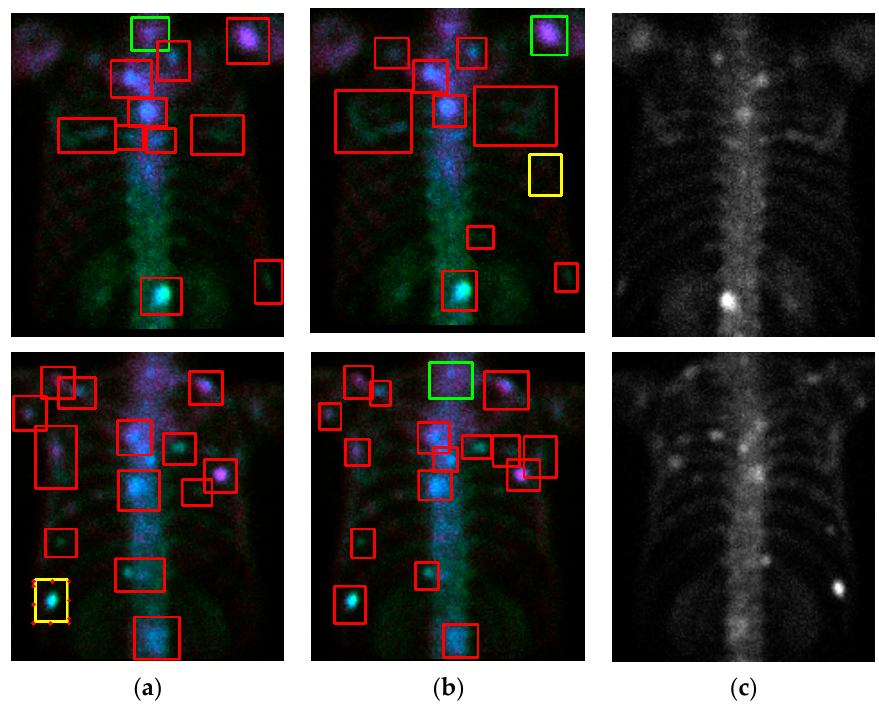
model. ( a ) Detection and classification results; ( b ) ground truth; ( c ) the raw PA view (without flip-